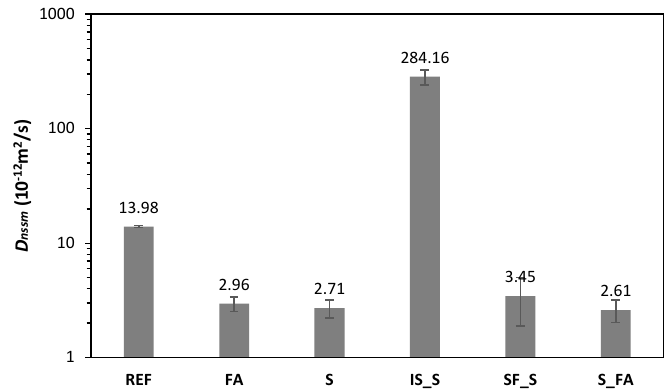
Figure 5. Apparent chloride migration coefficient measured after 28 days curing for all mixes according to NT BUILD 492.